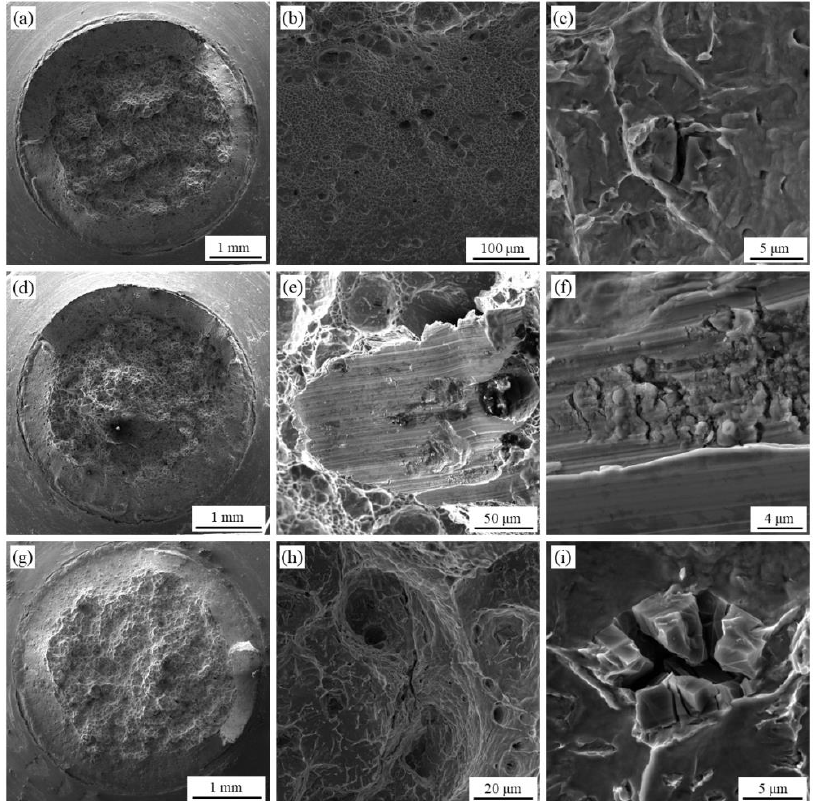
Figure 7. Micrographs of UNS S32205 reinforcement after slow strain rate test (SSRT) immersed in CBS: 0 wt.% Cl – ( a ) rupture surface ×50 ( b ) microvoids and coalescence of dimples ×550, ( c ) broken inclusions ×11,200; 4 wt.% Cl – ( d ) rupture surface ×50, ( e ) brittle fracture mode ×1200, ( f ) microcracks inside the ferrite cleavage facets ×10,300; 8 wt.% Cl – ( g ) rupture surface ×50, ( h ) cracks inside the ferrite cleavage facets ×3100, and ( i ) crack nucleation due to inclusions ×7600.